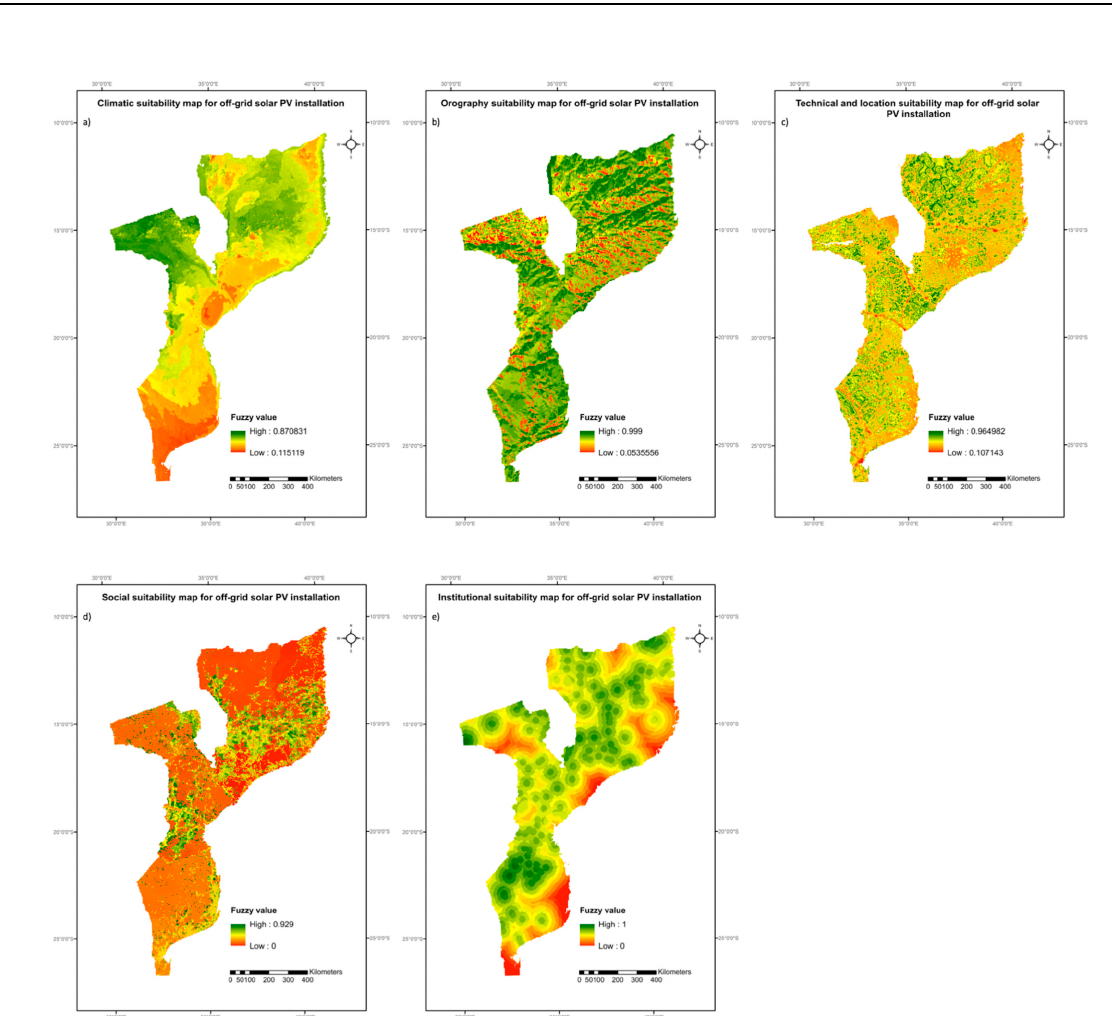
Figure 10. Initial suitability areas applied in the AHP. ( a ) Climatic, ( b ) orography, ( c ) technical and location, ( d ) social, and ( e ) institutional suitability map for off-grid solar PV microgrid deployment.